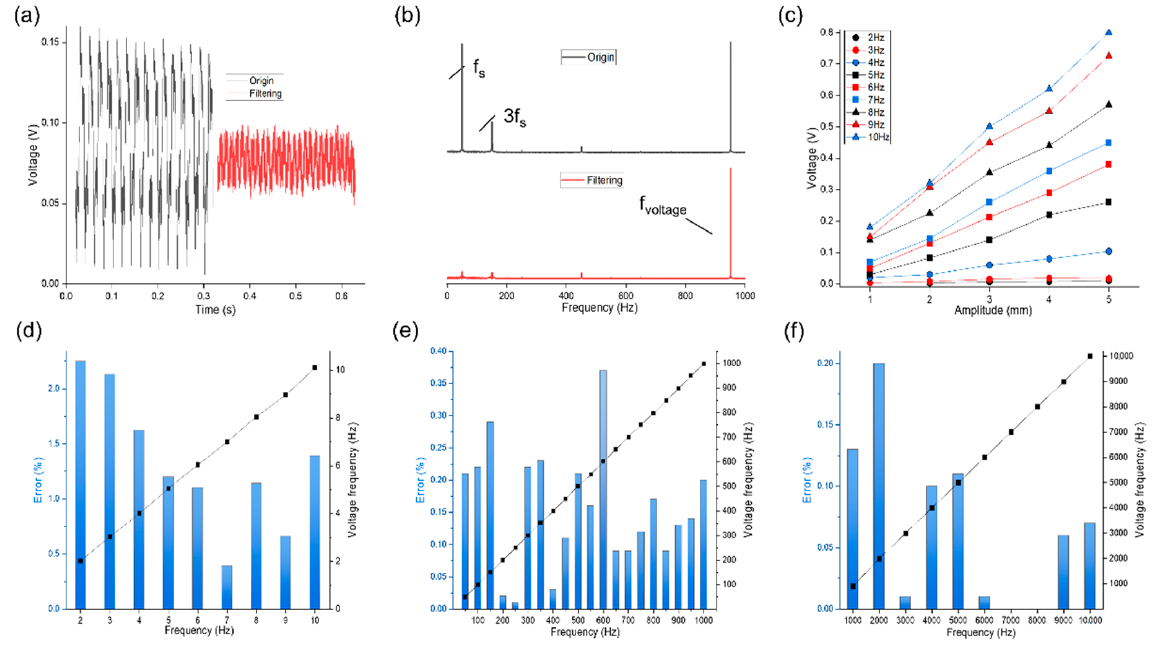
Figure 5. Working range of the ES − TENG sensor. ( a ) Comparison between the original and filtered voltage signals of ES − TENG at 950 Hz; ( b ) corresponding spectrograms; ( c ) voltage values of ES − TENG with different amplitudes at 2–10 Hz. FFT plots of V OC signals: ( d ) 2–10 Hz; ( e ) 10–1000 Hz; ( f ) 1000–10,000 Hz.